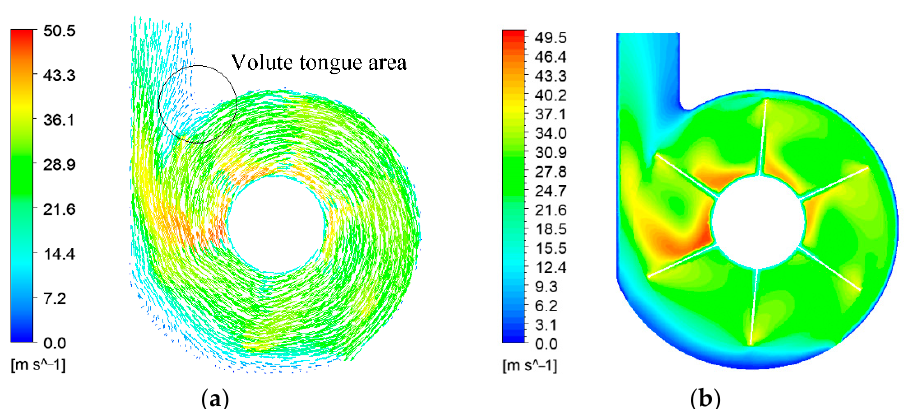
Figure 12. Velocity vector diagram of cross section 2 ( a ) and velocity nephogram of cross section 2